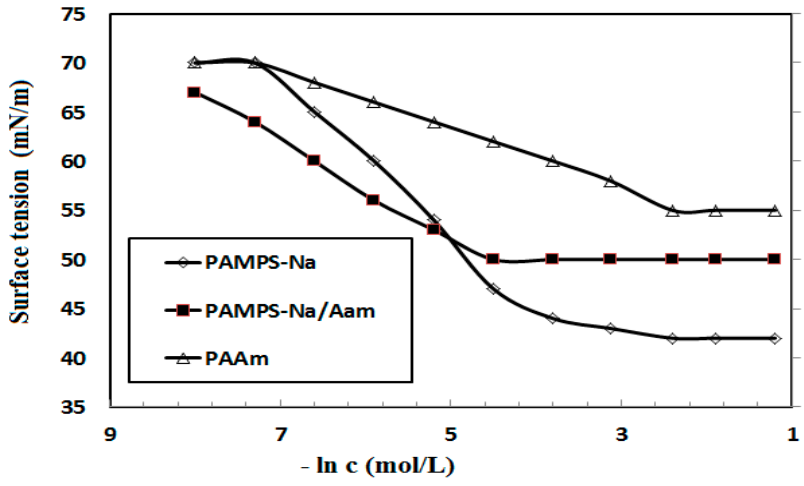
Figure 4 . Relation between surface tension and concentrations of nanogel composites at 25 °C.